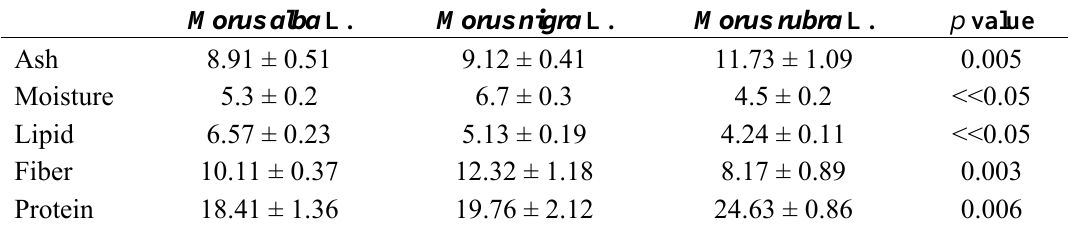
Table 1. Proximate composition of leaves from three varieties of